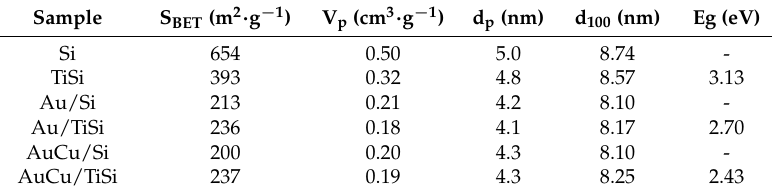
Table 1. Structural, textural, and optical properties of the as-prepared samples.